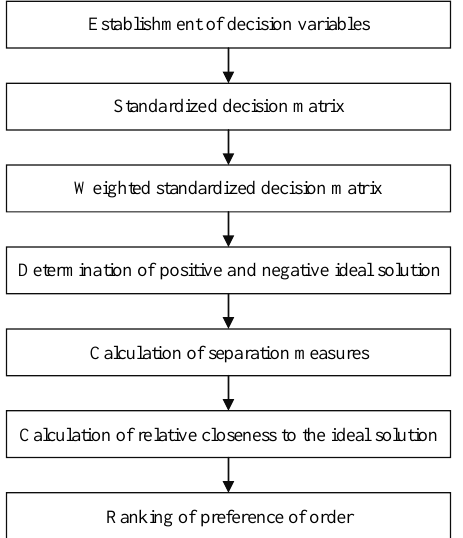
Fig. 3. The algorithm of multicriteria analysis